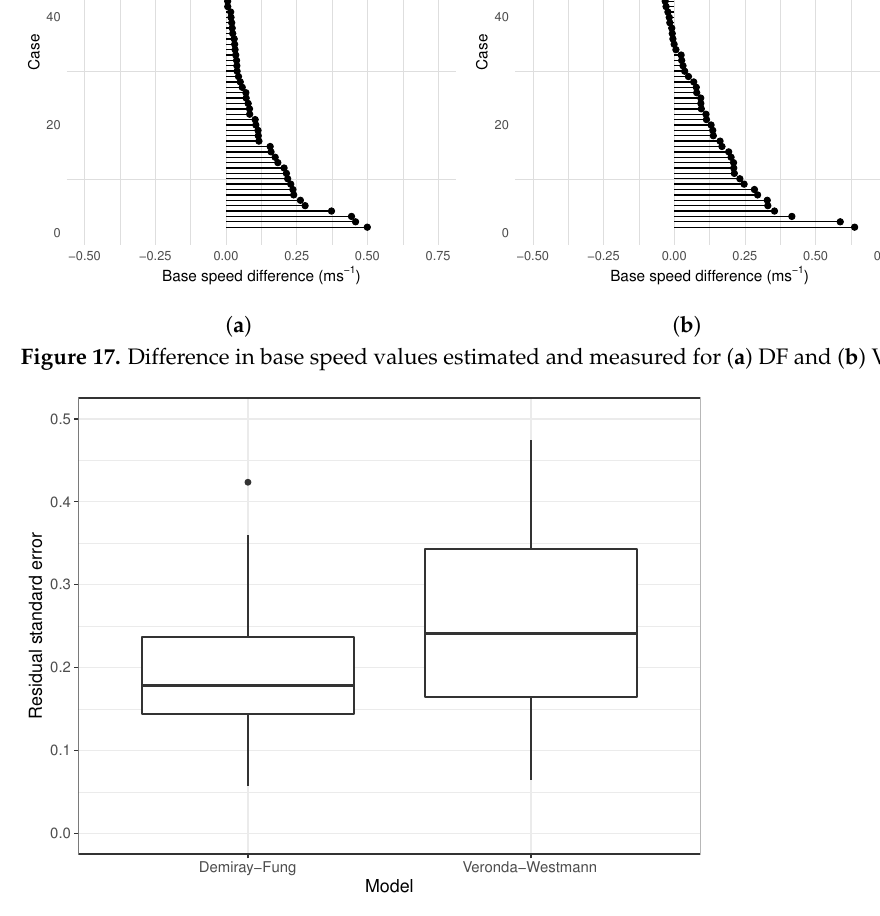
Figure 18. Residual standard error of the predicted proportional increase and the measured propor- tional increase for DF and VW material